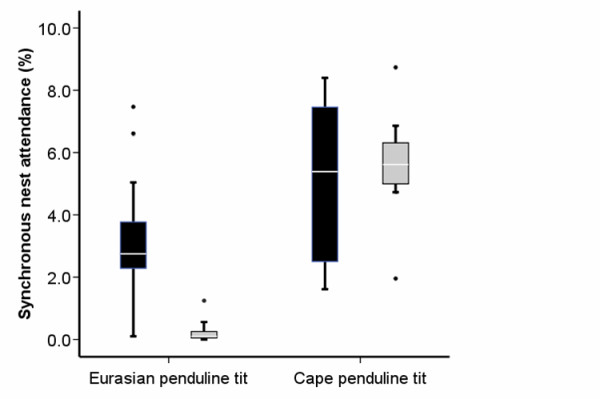
Expected (black boxes) and observed (shaded boxes) synchronous nest attendance by Eurasian (N = 21) and Cape penduline tit (N = 7) pairs. Boxplots show median, interquartile range, outliers and extreme cases.